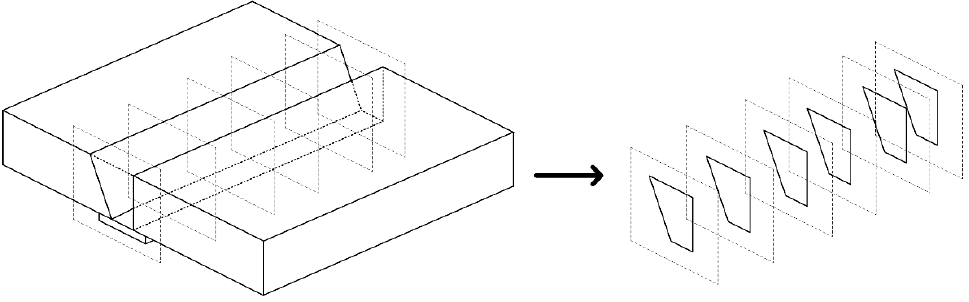
Figure 15. Multi-section division of groove.